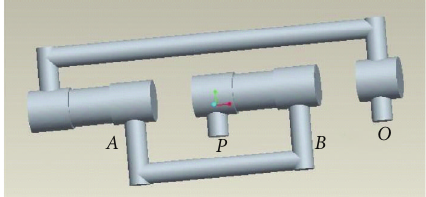
Figure 1: The constructed three dimensional model of target runner.